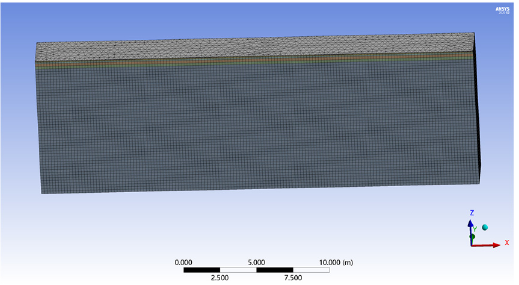
Figure 5. Road finite element model.